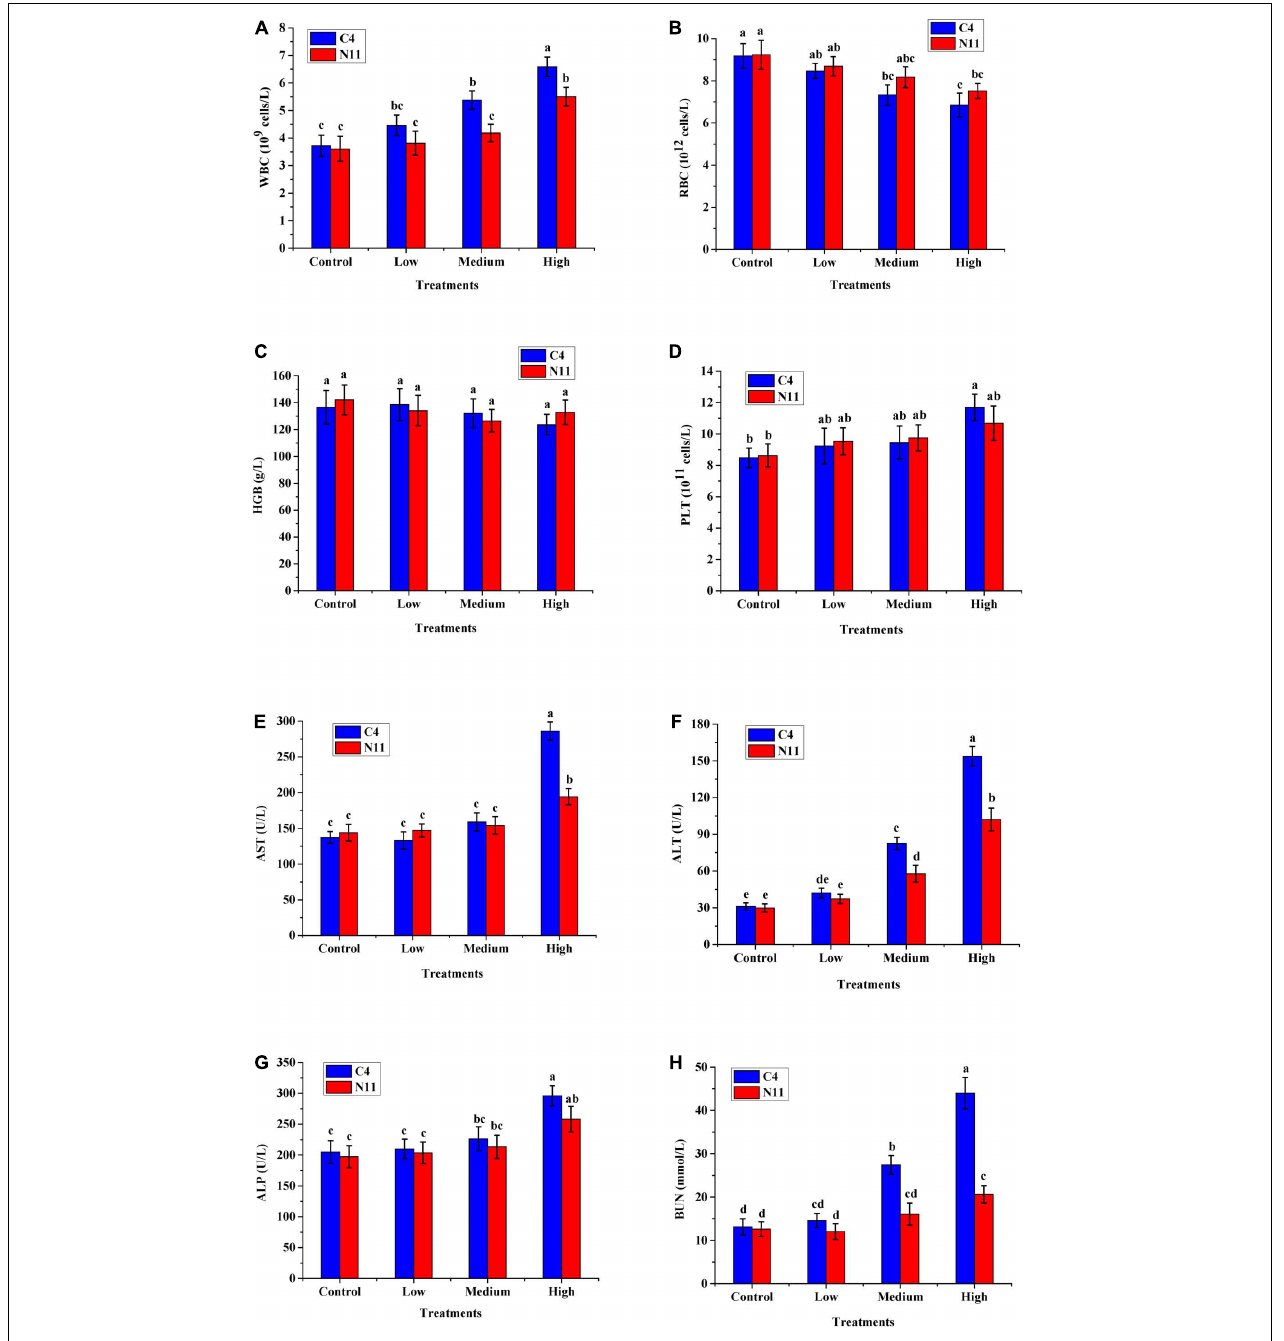
FIGURE 5 | In vivo virulence test results of the C4 and N11 strains 24 h after infection of mice by oral gavage. (A) White blood cells (WBC); (B) Red blood cells (RBC); (C) Hemoglobin (HGB); (D) Platelets (PLT); (E) Aminotransferase (AST); (F) Alanine aminotransferase (ALT); (G) Alkaline phosphatase (ALP); (H) Blood urea nitrogen